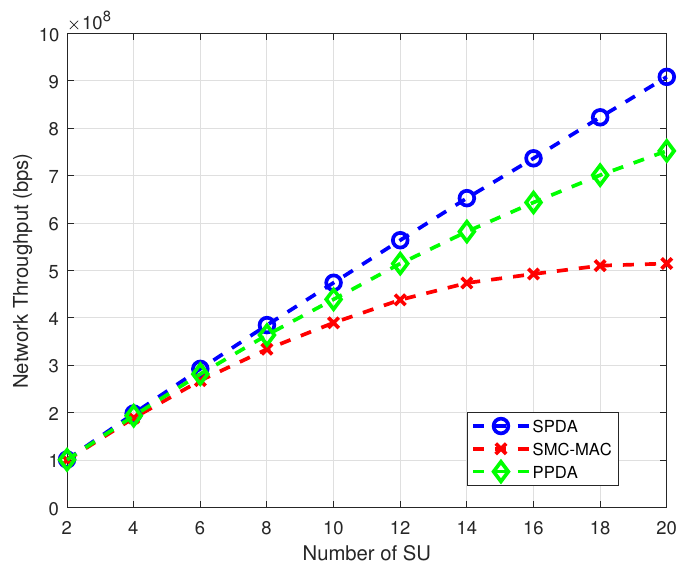
Figure 7. Network throughput at different number of SU.